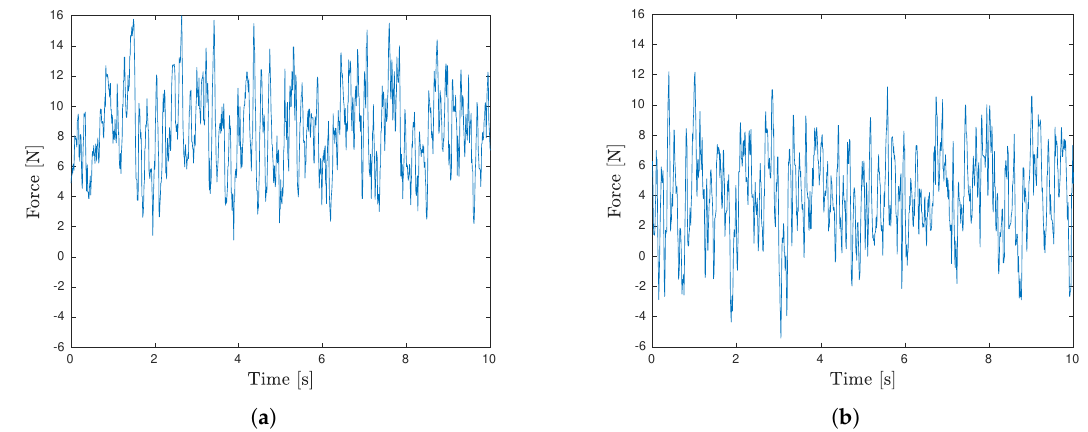
Figure 5. Time histories of interaction forces in the AP direction during walker-assisted walking in ( a ) condition 2 and ( b ) condition